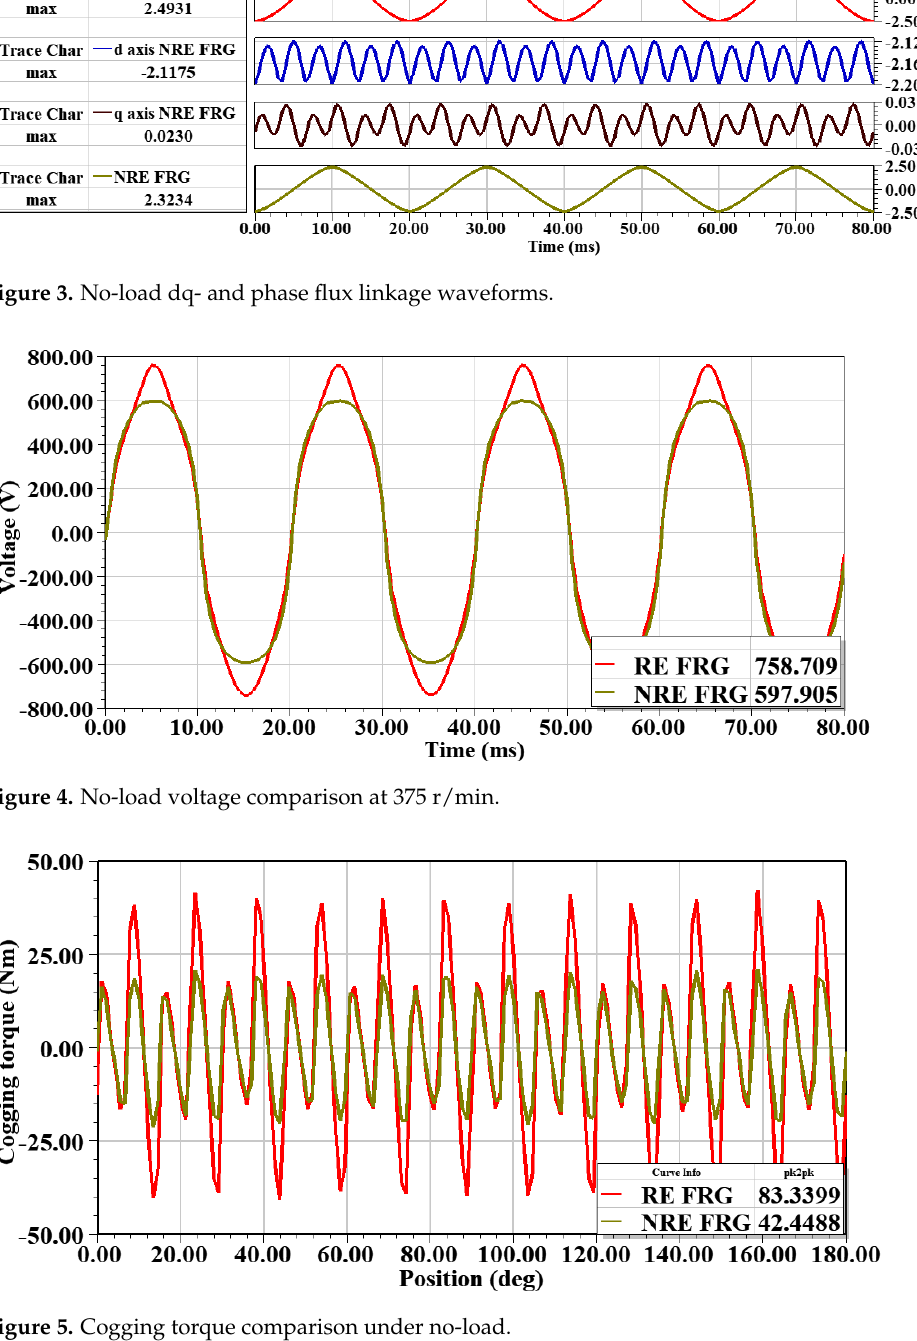
Figure 3. No-load dq- and phase flux linkage waveforms.